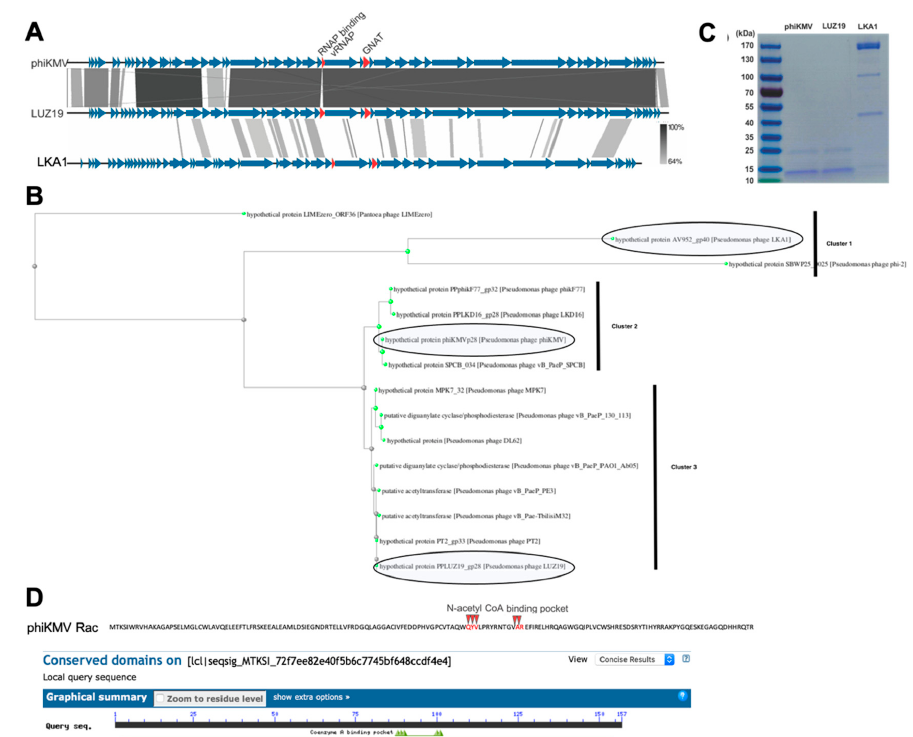
Figure A3. Conservation of Rac among members of Krylovirinae . ( A ) Genome comparison of phage phiKMV, LUZ19 and LKA1, scored according to tBLASTx comparison. Genes 25.1 and 28 are indicated with red arrows. ( B ) Phylogenetic tree (neighbor joining). ( C ) A ffi nity pull-down of P. aeruginosa rpoA::strep cells infected with phiKMV, LUZ19 and LKA1, followed by pull-down of the RNAP complex.